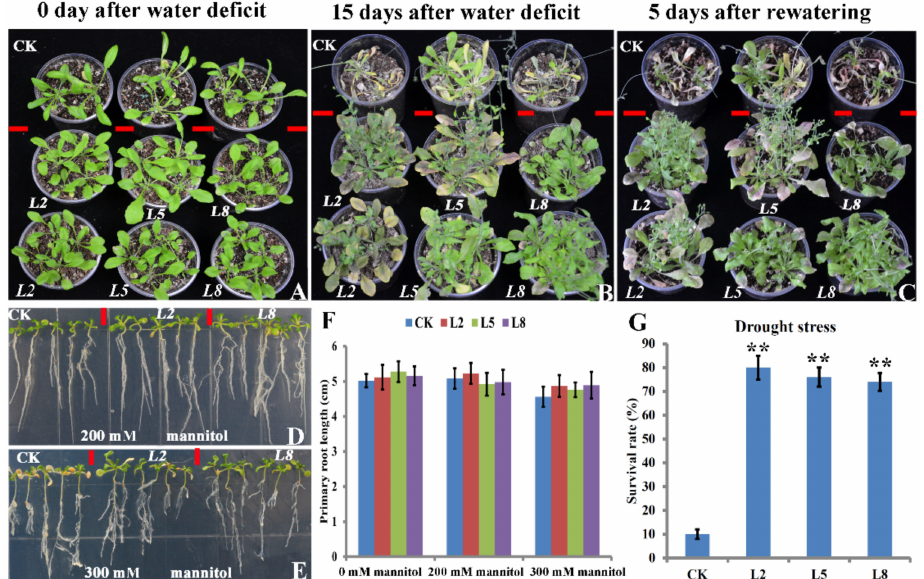
Figure 3. Phenotypes of transgenic Arabidopsis plants overexpressing bolTLP1 under drought stress. ( A , B ): Phenotypes of 35S:: bolTLP1 Arabidopsis at 0 day and 15 days after the water deficit. ( C ): Phenotypes of 35S:: bolTLP1 Arabidopsis at 5 days after rewatering. ( D , E ): Phenotypes of 14-day-old 35S:: bolTLP1 Arabidopsis seedlings growing in 1/2 MS medium with 200 mM and 300 mM mannitol, respectively. ( F ): Primary root length of 35S:: bolTLP1 transgenic Arabidopsis at 14 days after growing in 1/2 MS medium with 200 mM and 300 mM mannitol. ( G ): Survival rate of 35S:: bolTLP1 Arabidopsis at 5 days after rewatering. (Student’s t -test, ** p < 0.01; data are means ± SD ( n ≥ 20).) The top row of A, B and C showed the vector controls (CK), and the middle and bottom rows showed the independent 35S:: bolTLP1 Arabidopsis lines ( L2 , L5 and L8